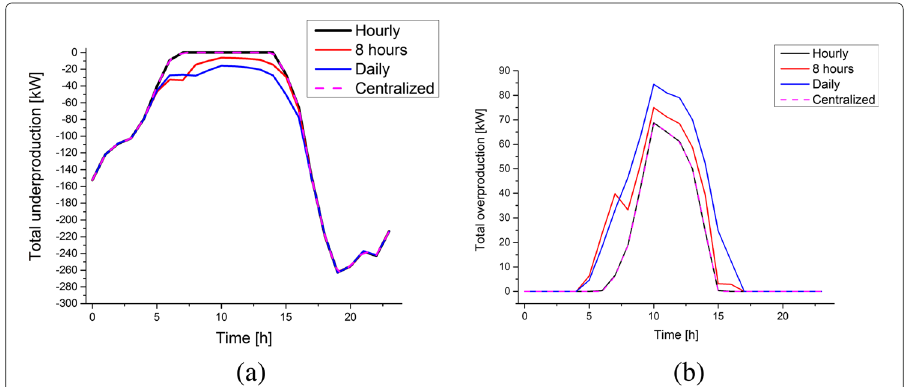
Fig. 5 Comparison of clustering mechanisms in terms of a total underproduction and b total overproduction